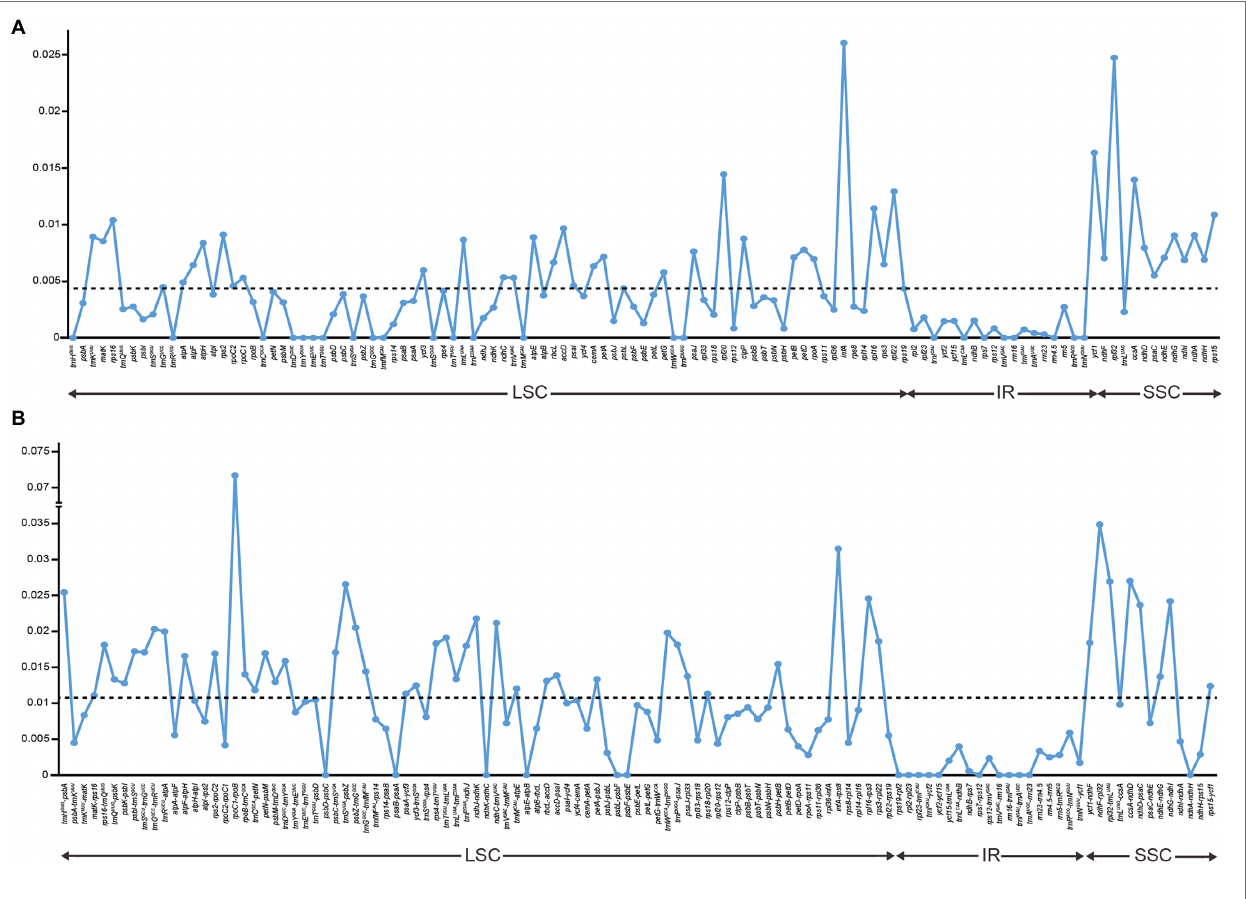
FIGURE 3 | Comparison of nucleotide variability ( π ) values in Thalictrum plastomes. (A) Pi values among genes, (B) Pi values among intergenic spacer (IGS) regions. The break in the middle of the bars indicated that other regions and genes are omitted here. The dot line denoted the average